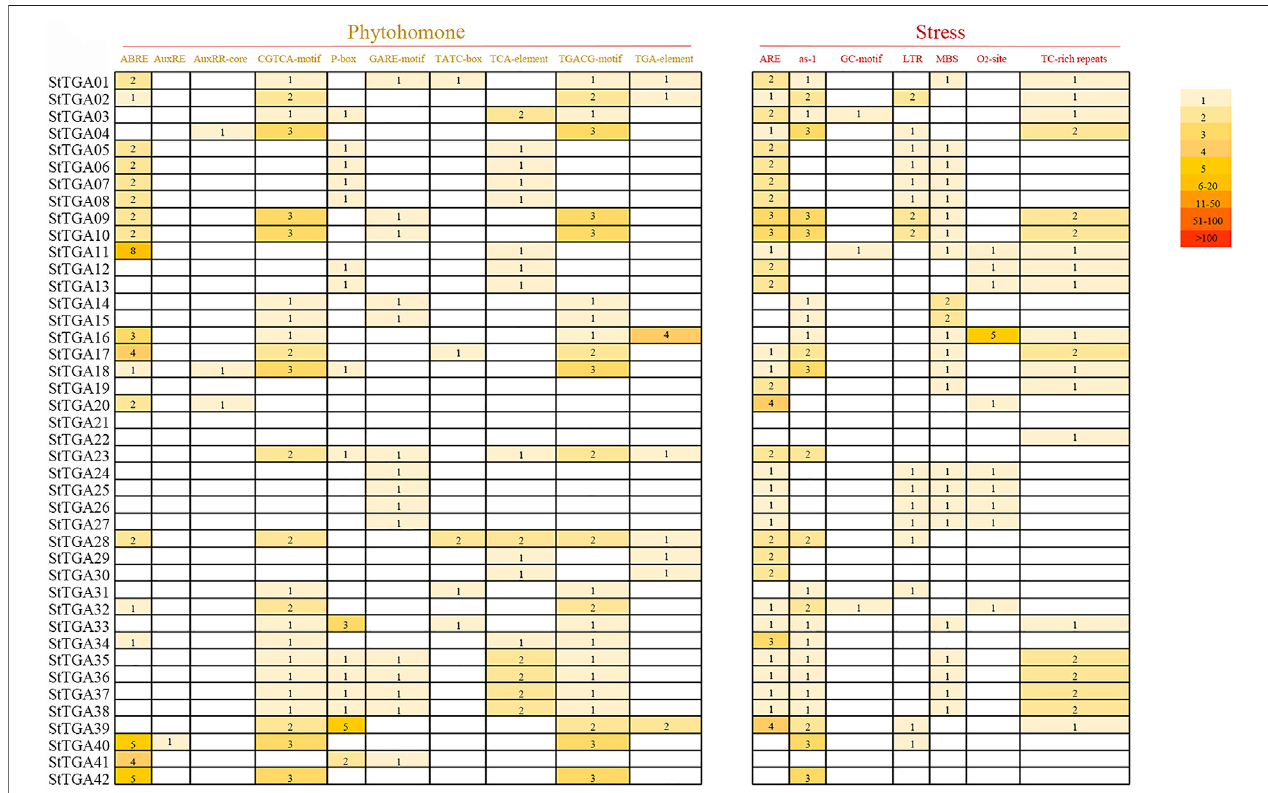
FIGURE 2 | Cis-acting elements analysis in the promoter regions of StTGA . The promoter cis-elements were analyzed by PlantCARE, and the number of ciselements was searched in the 2,000 bp region upstream of the translation initiation site of the StTGA gene. Cis-elements were divided into two different types: phytohomone and stress. Expressed by different colors according to their number. The darker the color, the higher the frequency of appearance, and the number indicates the number of